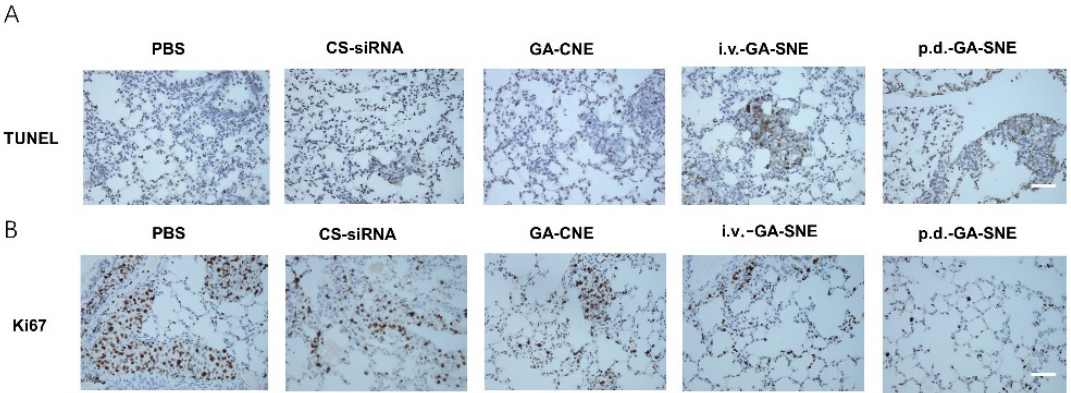
Figure 6. Analysis of murine tumor model treated with GA-CNE. ( A ) TUNEL analysis in the tumor region slices after all treatments. Scale bar: 100 µ m ( B ) IHC analysis of Ki67 in the tumor region slices after all treatments. Scale bar: 100 µ